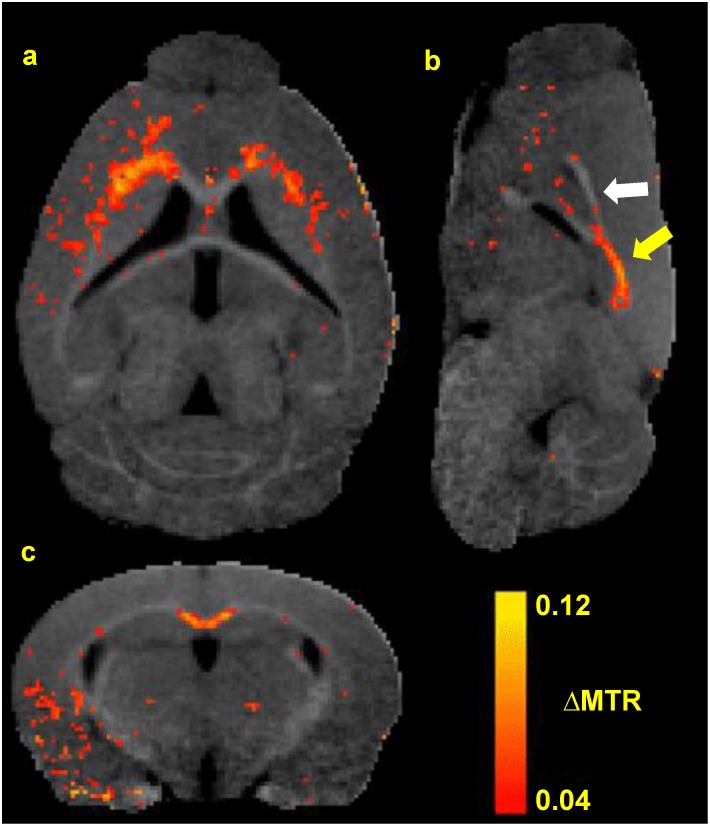
Population Average Week 6 ΔMTR Parametric Maps.Horizontal (a), sagittal (b), and coronal (c) views of the mouse brain. Color overlay represents areas of MTR decrease (paired t-test, p<0.01) after 6 weeks of cuprizone as compared to baseline. The caudal-rostral pattern of demyelination along the midline is illustrated in panel b (arrows).